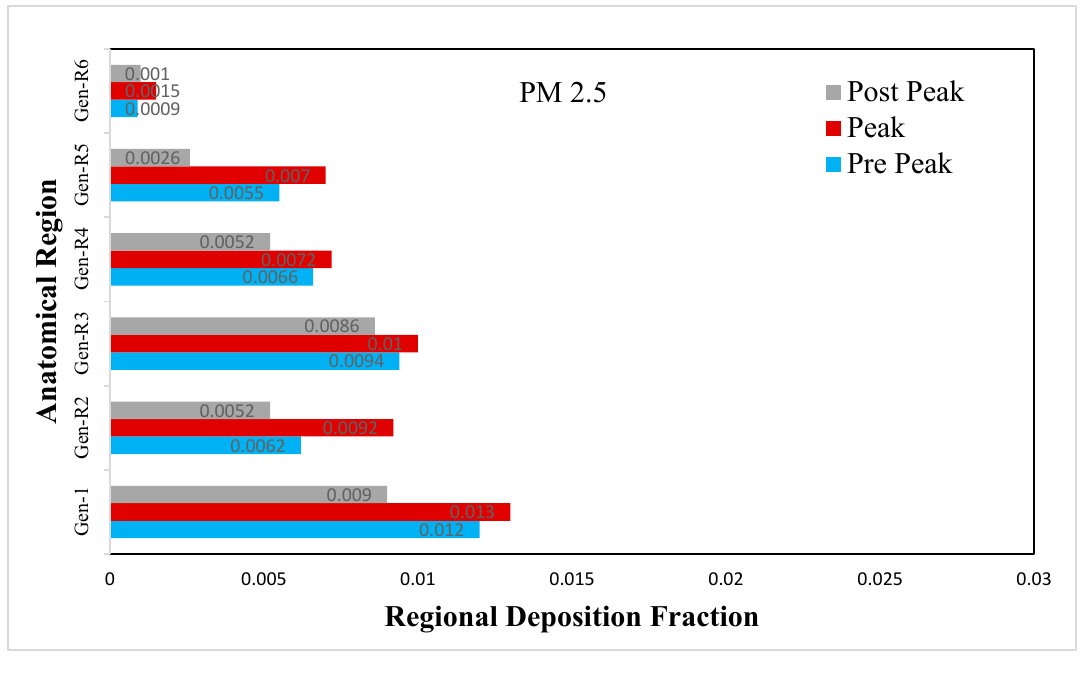
(a) ( i ) Right bronchial tree Figure 9. Cont